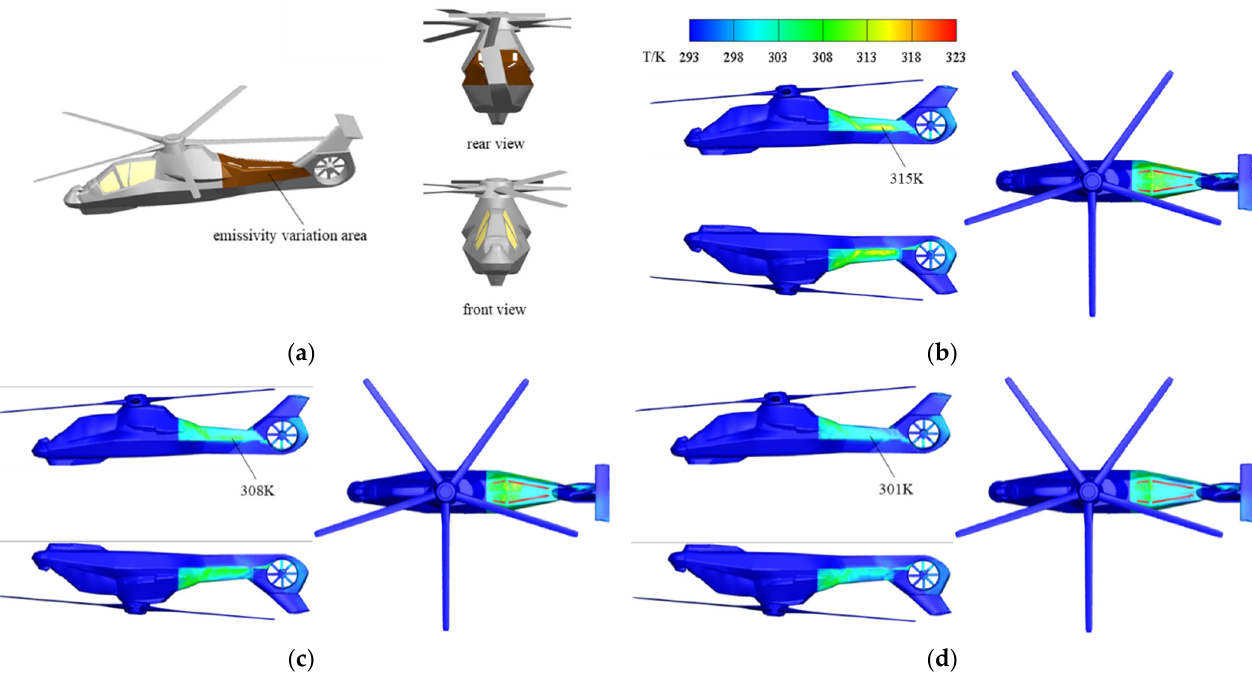
Figure 13. Temperature distribution of the fuselage surface. ( a ) Schematic of emissivity variation area; ( b ) emissivity—0.8; ( c ) emissivity—0.5; and ( d ) emissivity—0.2. area; ( b ) emissivity—0.8; ( c ) emissivity—0.5; and ( d )